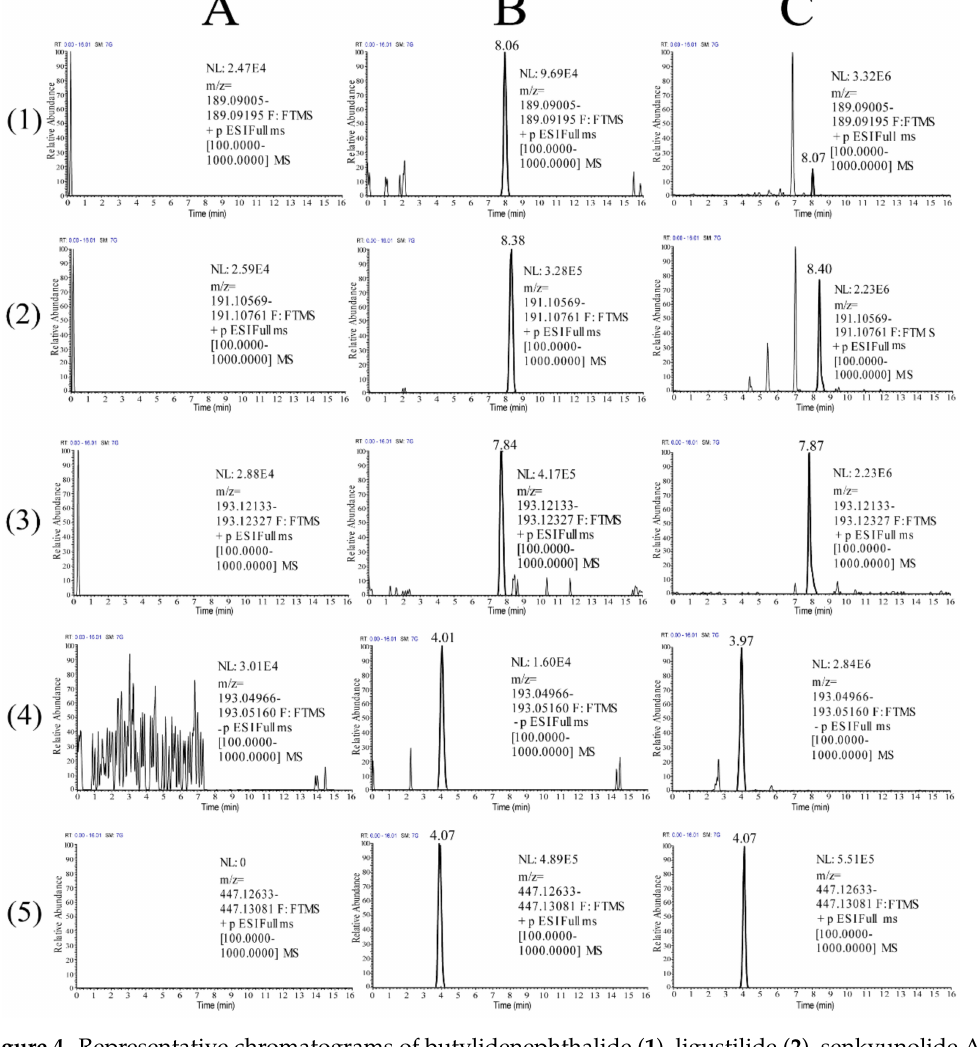
Figure 4. Representative chromatograms of butylidenephthalide ( 1 ), ligustilide ( 2 ), senkyunolide A ( 3 ), ferulic acid ( 4 ) and calycosin-7- O - β - d -glucoside (IS) ( 5 ) in rat plasmas: ( A ) blank plasma samples; ( B ) blank plasma samples spiked with butylidenephthalide, ligustilide, senkyunolide A, ferulic acid at linearity and lower limit of quantitation (LLOQ) and IS; ( C ) plasma samples obtained at 1 h after oral administration of RCR at a dose of 24.01 g /